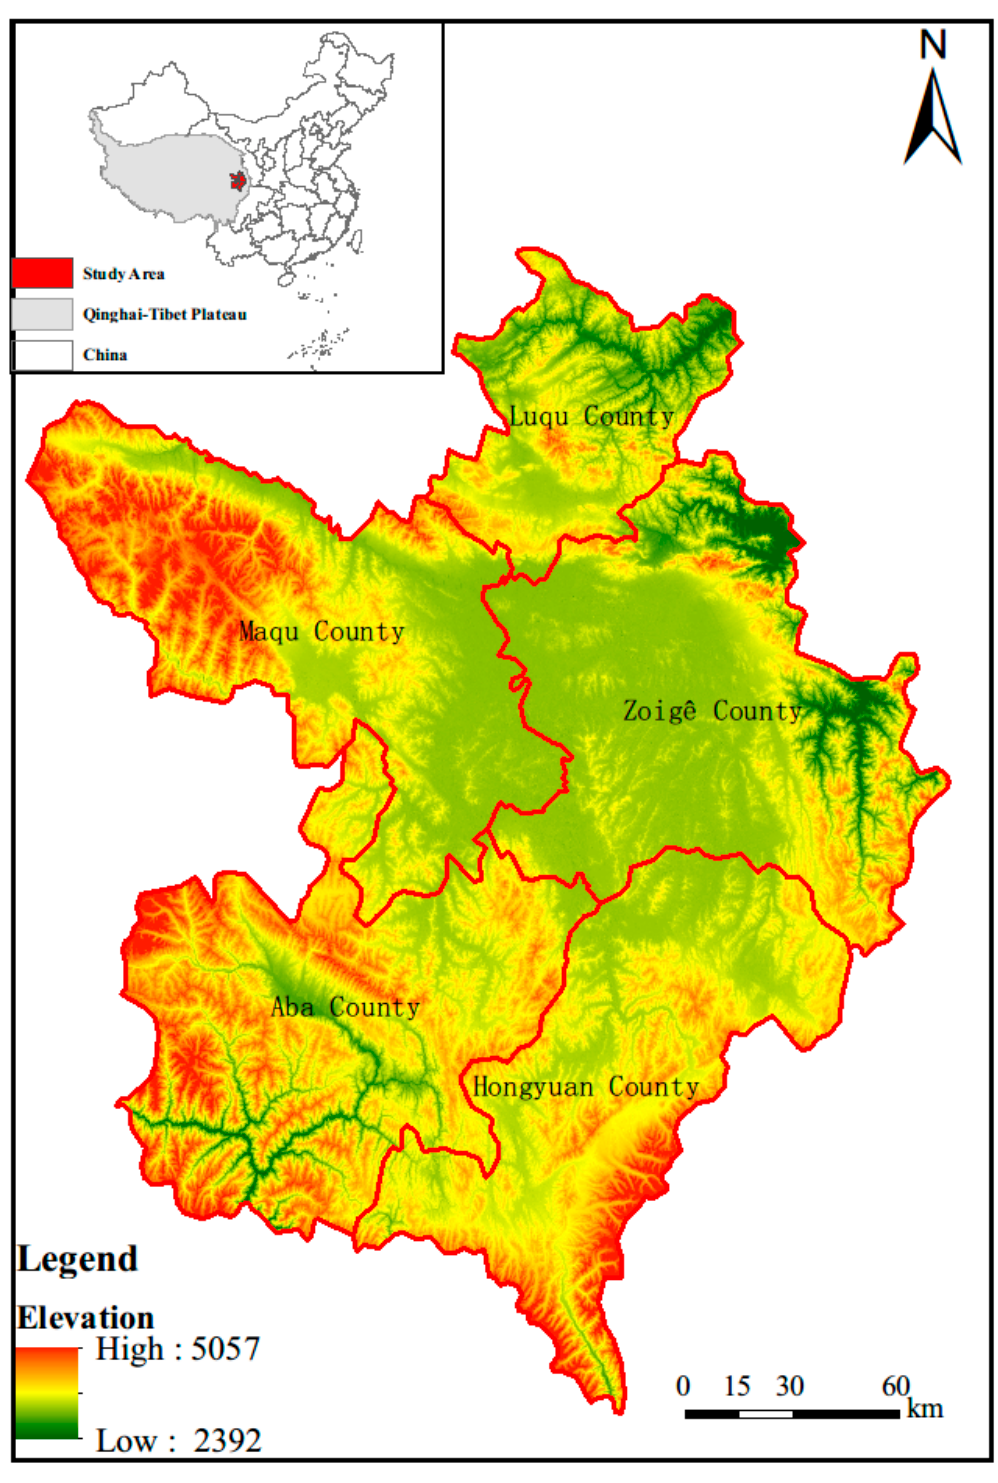
Figure 1. Location of Zoige Plateau (ZP).